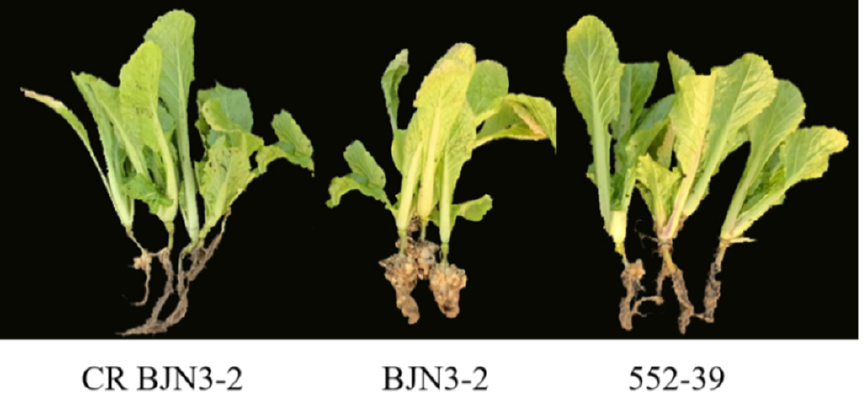
Figure 6. Phenotypic investigation of clubroot resistance for the pyramided line and two parental lines. CR BJN3-2: recurrent parent; BJN3-2: susceptible line as control; 552-39: selected pyramided line. Table 2. Phenotypic investigation of clubroot resistance.